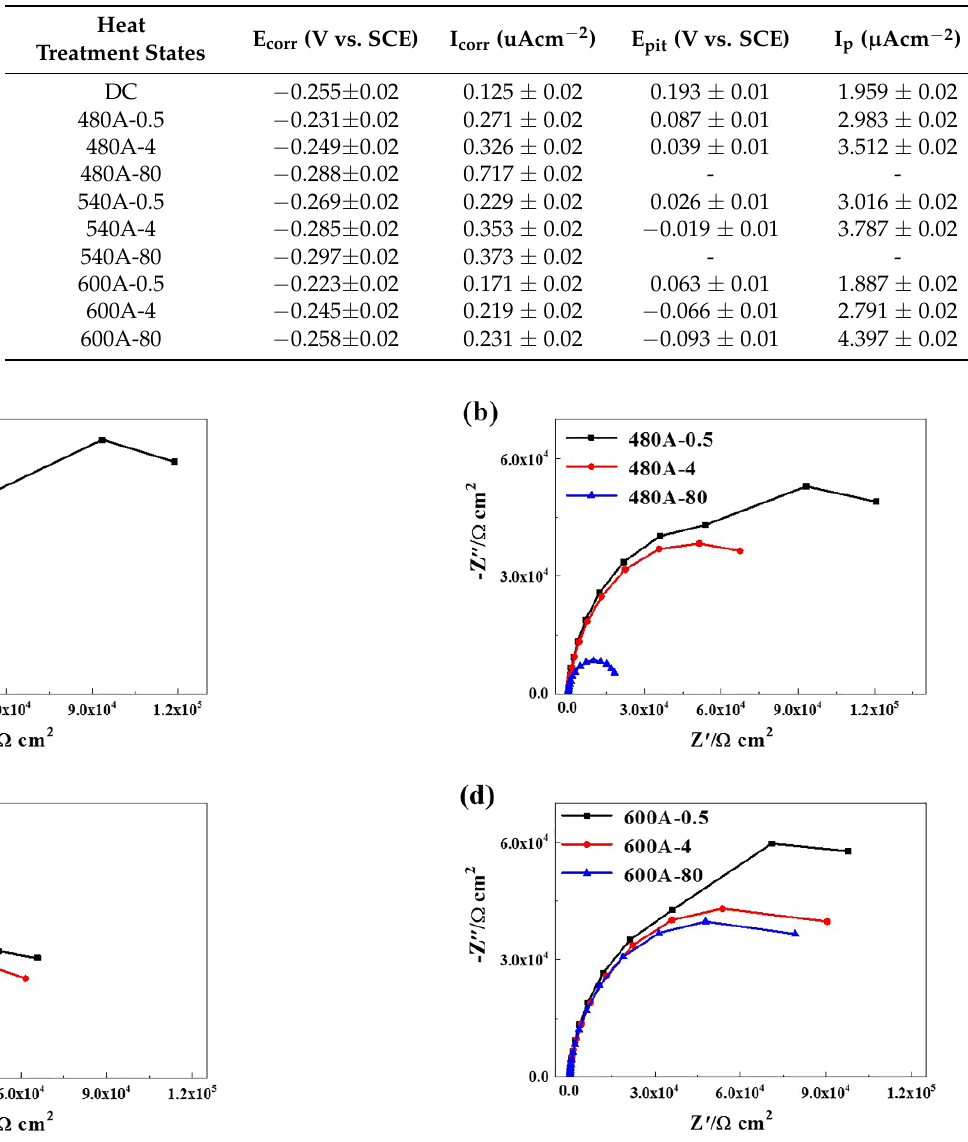
Figure 7. Nyquist diagram of samples under various thermal conditions: ( a ) DC, ( b ) 480A-0.5/480A- 4/480A-80, ( c ) 540A-0.5/540A-4/540A-80, and ( d ) 600A-0.5/600A-4/600A-80.